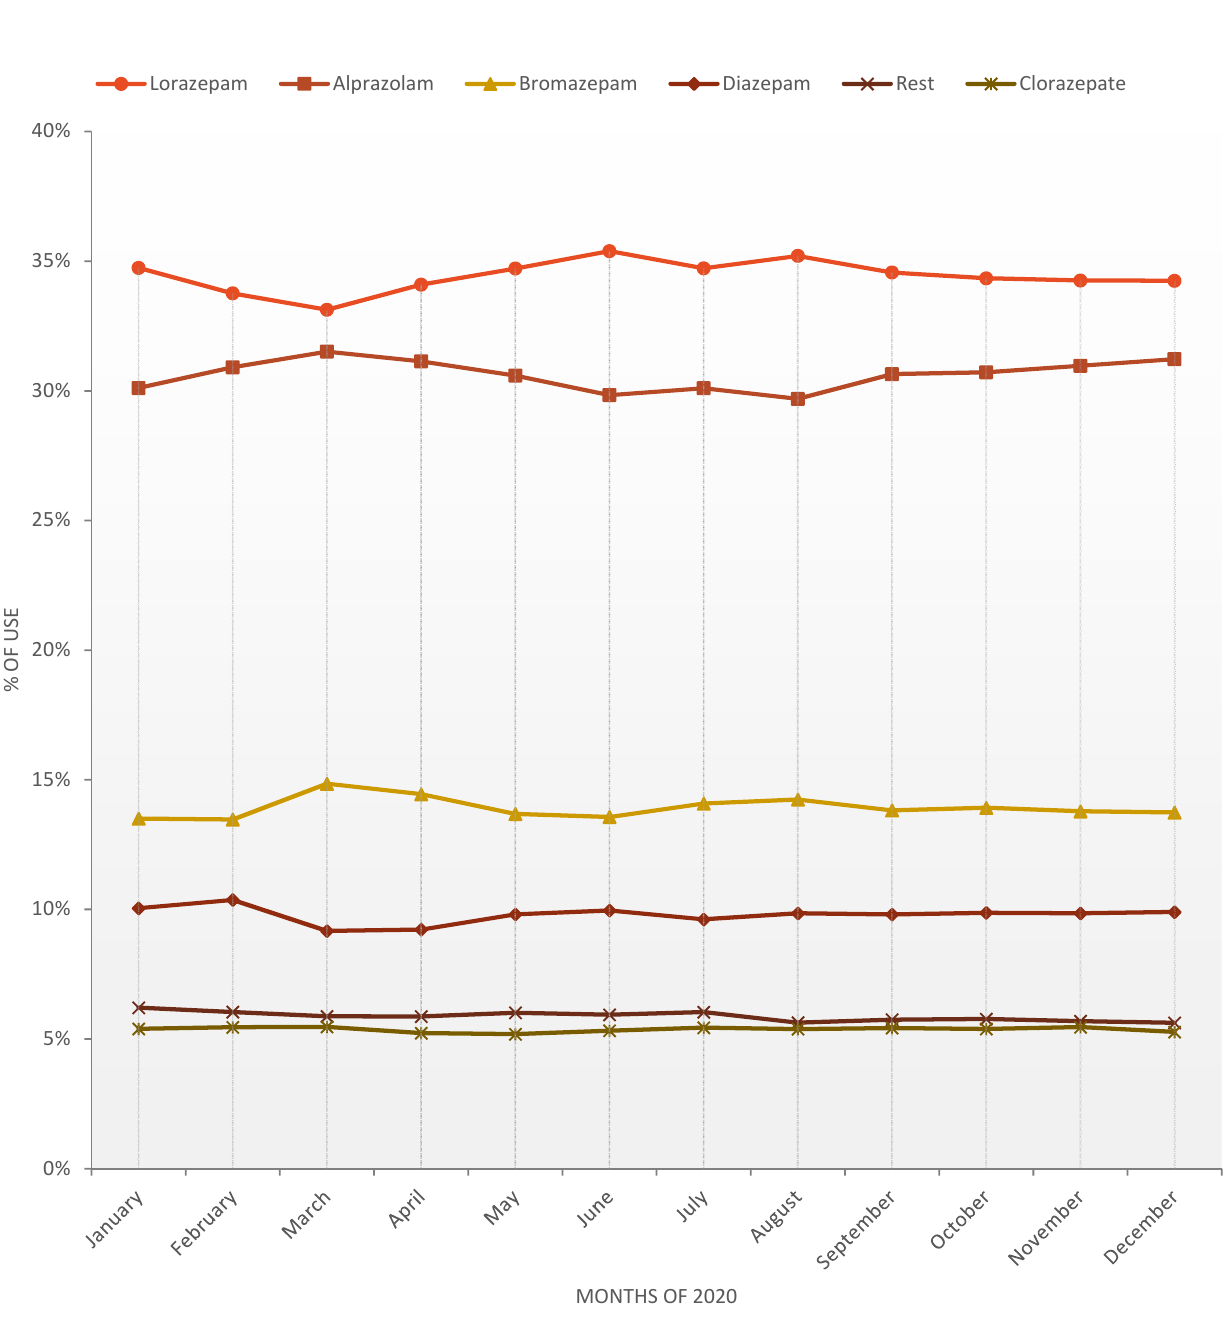
Figure 4. Progression of the use of anxiolytic drugs as a percentage in 2020.